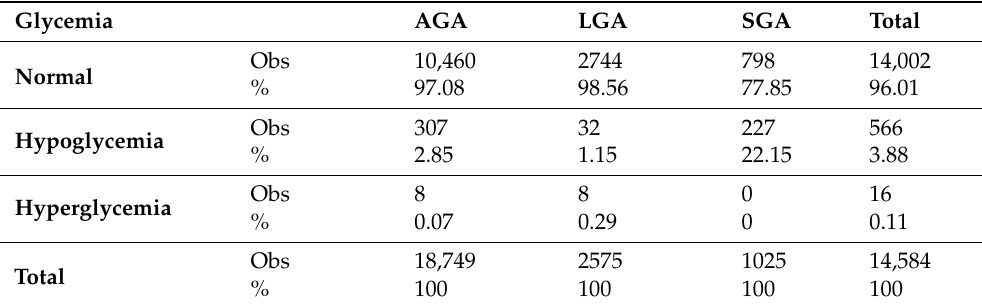
Table 7. Variance ratio test based on nutrition strategy AGA, appropriate for gestational age; SGA, small for gestational age; LGA, large for gestational age.